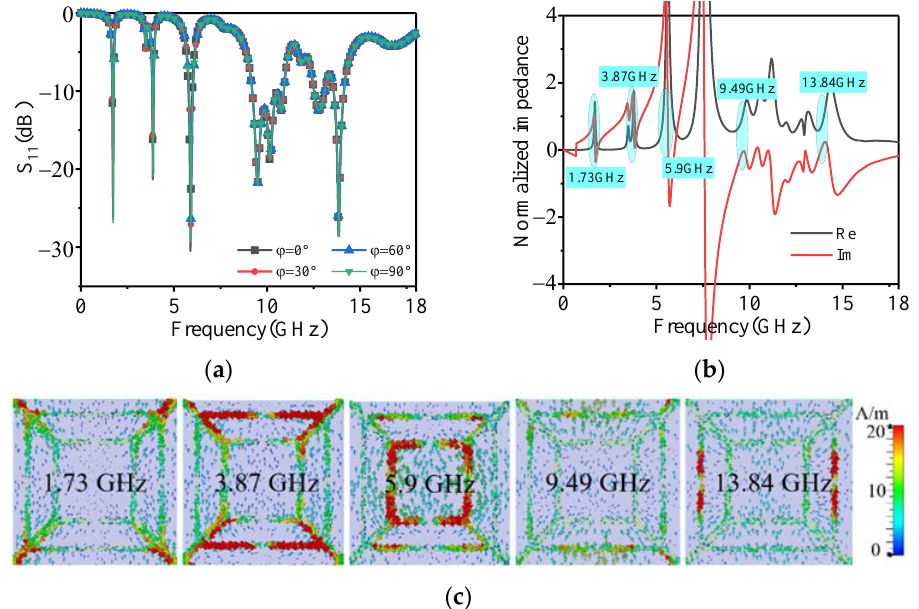
Figure 3. ( a ) S 11 under different polarization angles, when the incident angle is fixed to 0°. ( b ) The normalized impedance near each resonant point. ( c ) The current at different frequencies in the top surface.